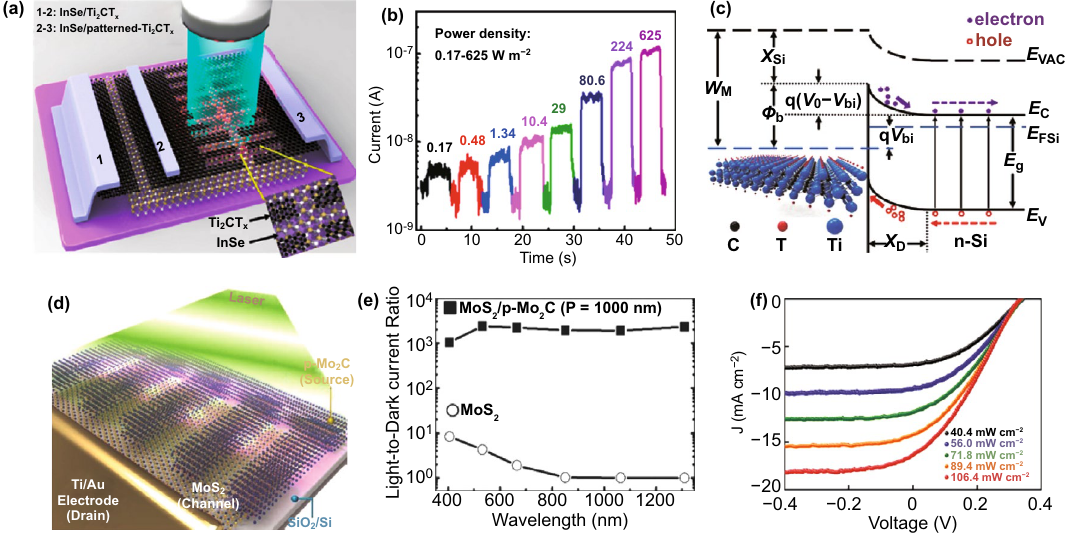
Fig. 11 Photoelectrical property of TMCs. a Schematic of unpatterned and patterned InSe/Ti 2 CT x photodetectors. b Photoresponse curves of patterned InSe/Ti 2 CT x avalanche photodetector under different illumination densities. Reproduced with permission from Ref. [197]. Copyright 2019, American Chemical Society. c Energy band diagram of Ti 3 C 2 T x /n-Si Schottky junction upon illumination [199]. d Schematic figure of photodetector device with MoS 2 /p-Mo 2 C hybrid structure under illumination. e I D –V G curves of photodetector device with MoS 2 /p-Mo 2 C hybrid structure under illumination with various wavelengths. Reproduced with permission from Ref. [201]. Copyright 2019, WILEY–VCH. f J–V curves of Ti 3 C 2 T x /n-Si heterostructure device under various energy density illuminations. Reproduced with permission from Ref. [199]. Copy- right 2017,